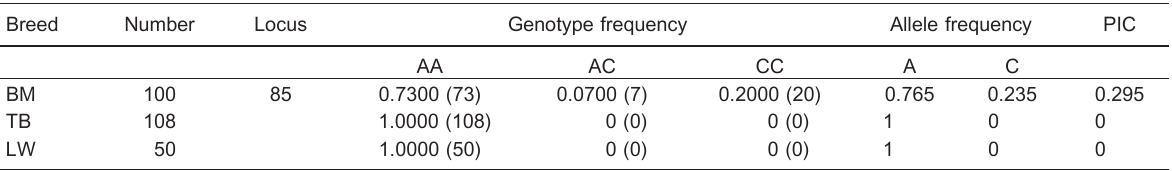
Table 2. Genotype and allele frequency of GHR gene in three pig breeds. Breed